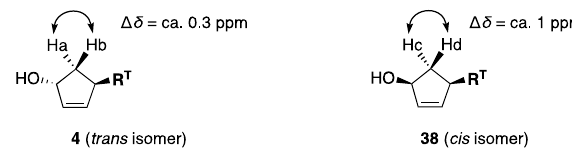
Figure 4. Chemical shift difference ( Δδ ).